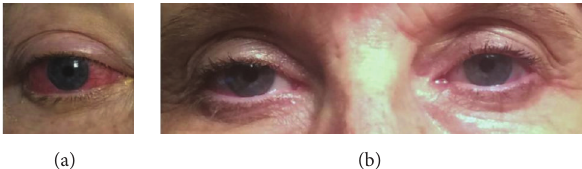
Figure 1: Patient’s eye findings on presentation (a) and 1 month after embolization (b). Initial periorbital edema, chemosis, proptosis, and conjunctival injection dramatically improved with